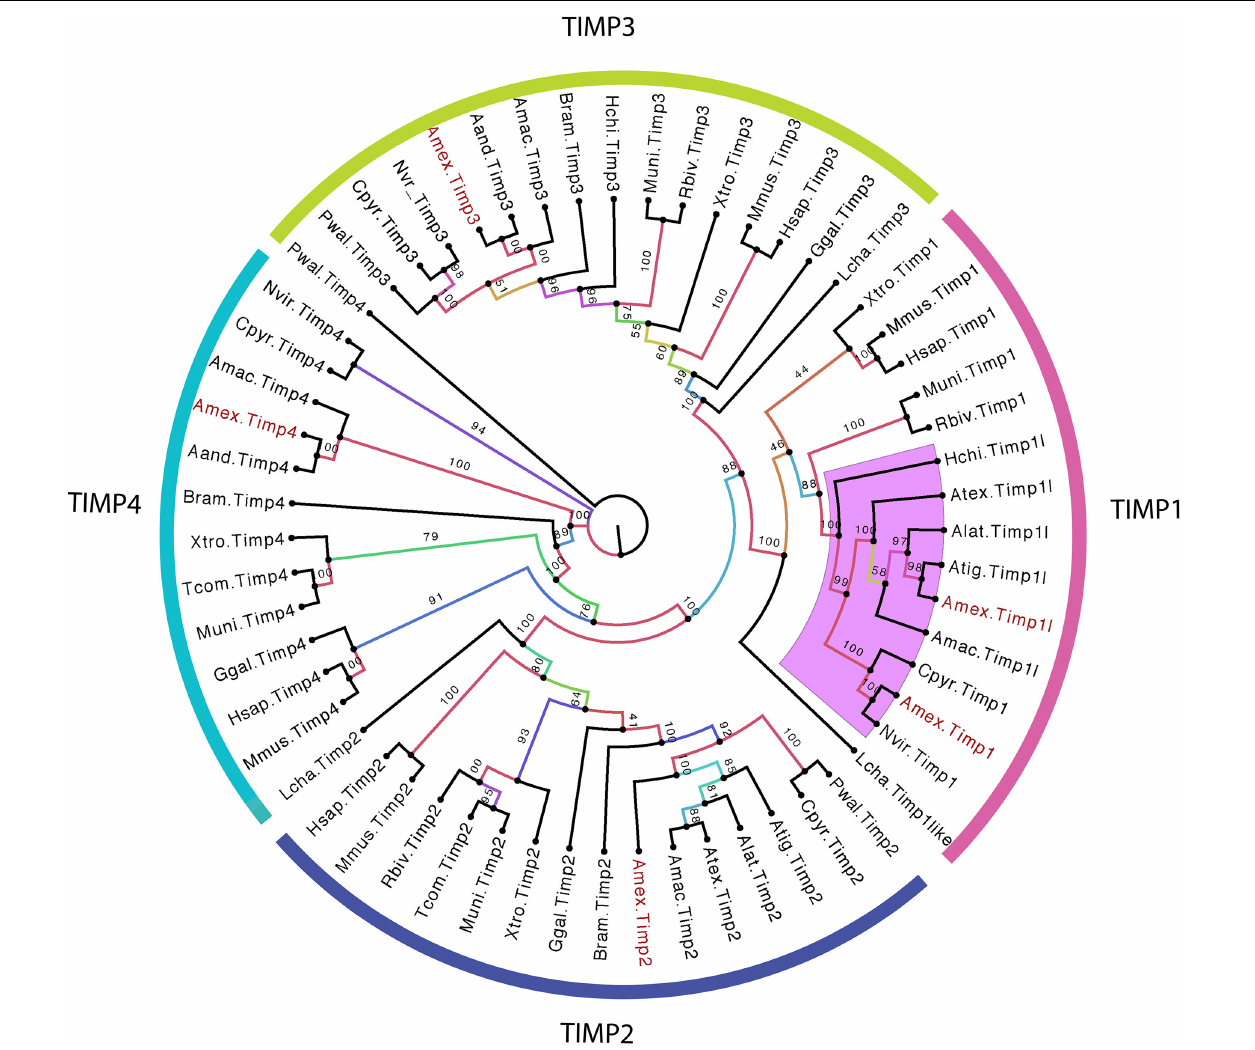
FIGURE 6 | Conservative TIMP gene family expansion in salamanders. Unrooted maximum likelihood phylogenetic tree of tetrapod TIMPs. Numbers on tree branches represent the bootstrap values, and every clade of TIMPs is annotated according to TIMPs type clustered. All axolotl TIMPs are colored in red. Purple-highlighted clades indicate salamander-specific TIMP expansions. The abbreviation for species used in transcript identifiers are: Ambystoma mexiacunm (Amex), Ambystoma tigrinum (Atig), Ambystoma laterale (Alat), Ambystoma andersoni (Aand), Ambystoma maculatum (Amac), Ambystoma texanum (Atex), Cynops pyrrhogaster (Cpyr), Bolitoglossa ramosi (Bram), Notophthalmus viridescens (Nvir), Pleurodeles waltl (Pwal), Hynobius chinensis (Hchi), Rhinatrema bivittatum (Rbiv), Microcaecilia unicolor (Muni), Typhlonectes compressicauda (Tcom), Xenpous tropicalis (Xtro), Gallus gallus (Ggal), Mus musculus (Mmus), Homo sapiens (Hsap), and Latimeria chalumnae